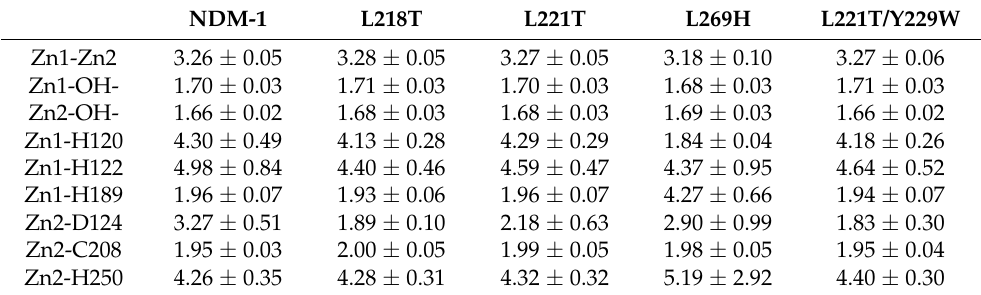
Table 4. Average distances in Å between Zn and their coordinating atoms, collected from the trajectory.